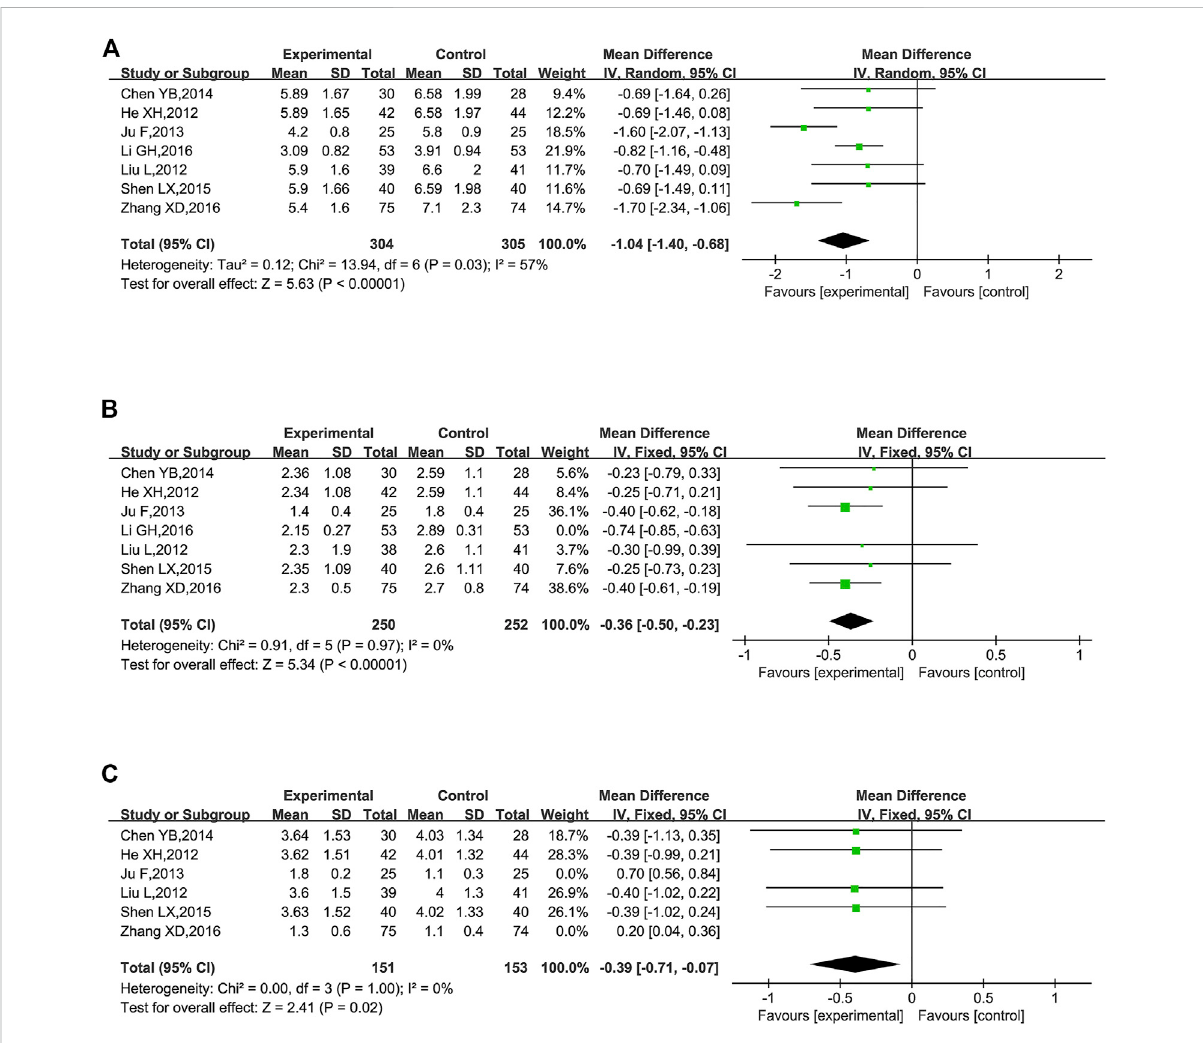
FIGURE 10 Forest plot of lipids for KLXC + Western medicine vs. Western medicine alone (mmol/L). (A) Forest plot of TC for KLXC + Western medicine vs. Western medicine alone. (B) Forest plot of TG for KLXC + Western medicine vs. Western medicine alone. (C) Forest plot of LDL for KLXC + Western medicine vs. Western medicine